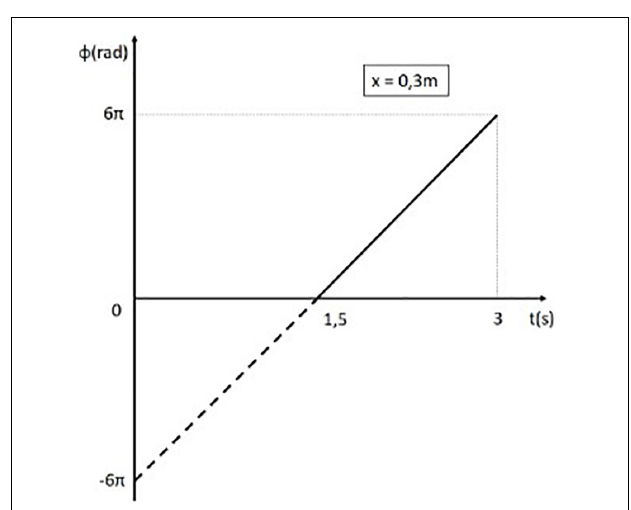
FIGURE 13 | Phase-time graph for